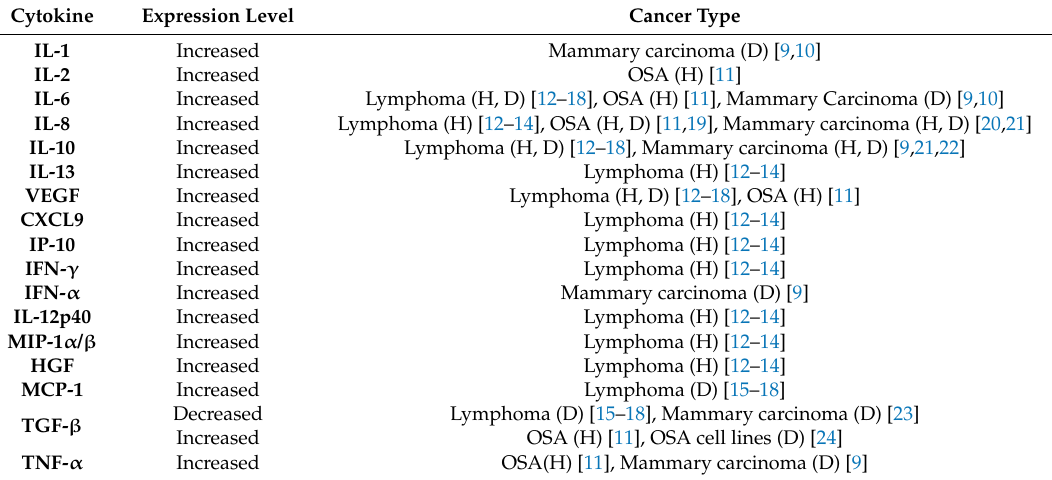
Table 1. Comparative cytokine expression in serum and tissue samples of human and canine